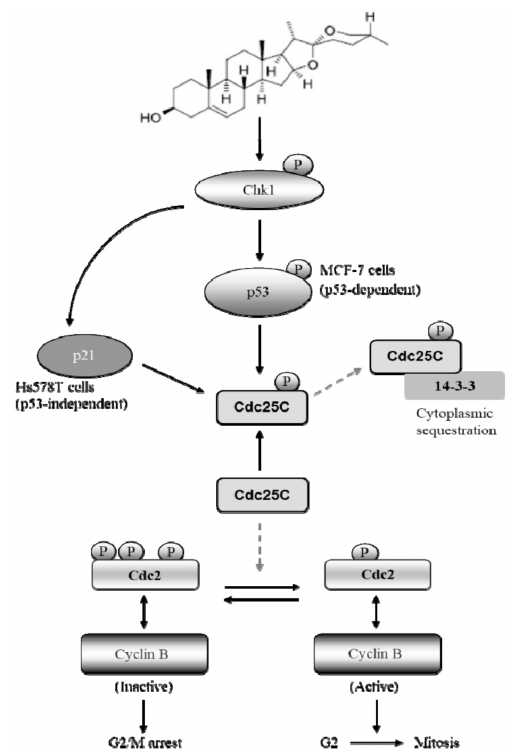
Figure 5. Model showing the proposed molecular mechanism of diosgenin-induced mitochondria- dependent apoptosis via checkpoint kinase activation in breast cancer cells. In this model, solid arrows show positive activation pathways determined in our studies. Gray arrows indicate functions reported previously [27]. The model suggests that diosgenin phosphorylates (activates) Chk1 at Ser345, leading to inactivation of the downstream target protein, phospho-Cdc25C Ser216 . Alternatively, inhibition of Cdc2 / cyclin B via phosphorylated Chk1-Cdc25C signaling results in G2 / M phase arrest that can cause p53-independent p21 activation, as shown in Hs578T